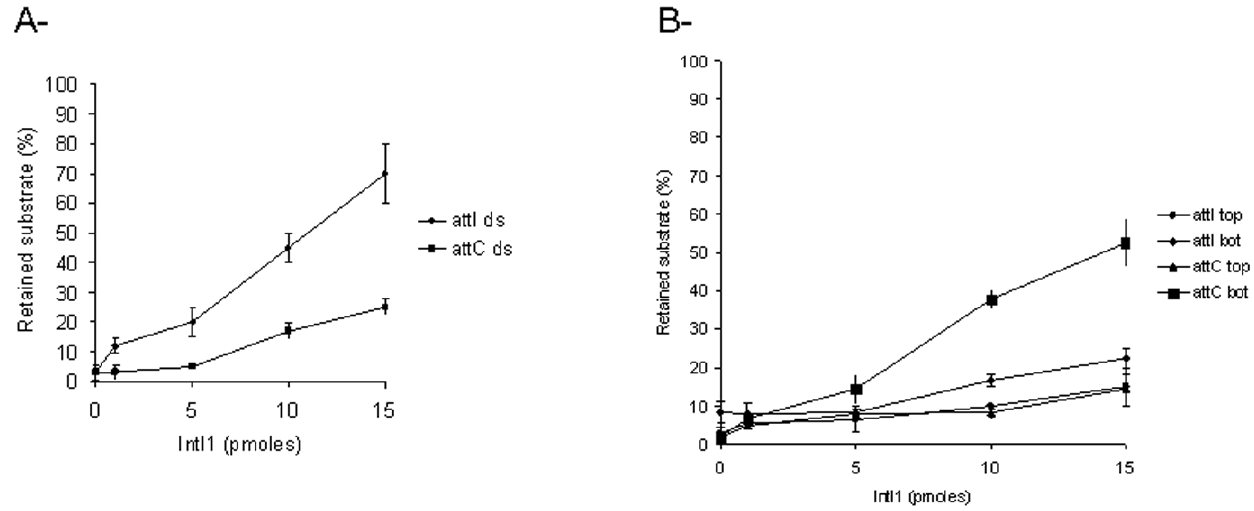
Figure 5. Comparison of IntI1 1 affinity for double-stranded (A) and single-stranded (B) recombination sites. Filter binding assays were performed as described in materials and methods section using either double-stranded attI ( attI ds ) and attC ( attC ds ) either top (top) or bottom (bot) strand of attI and attC. Percentages of substrate retained on filters are shown. Values are the mean 6 standard deviation (error bars) of three independent experiments.